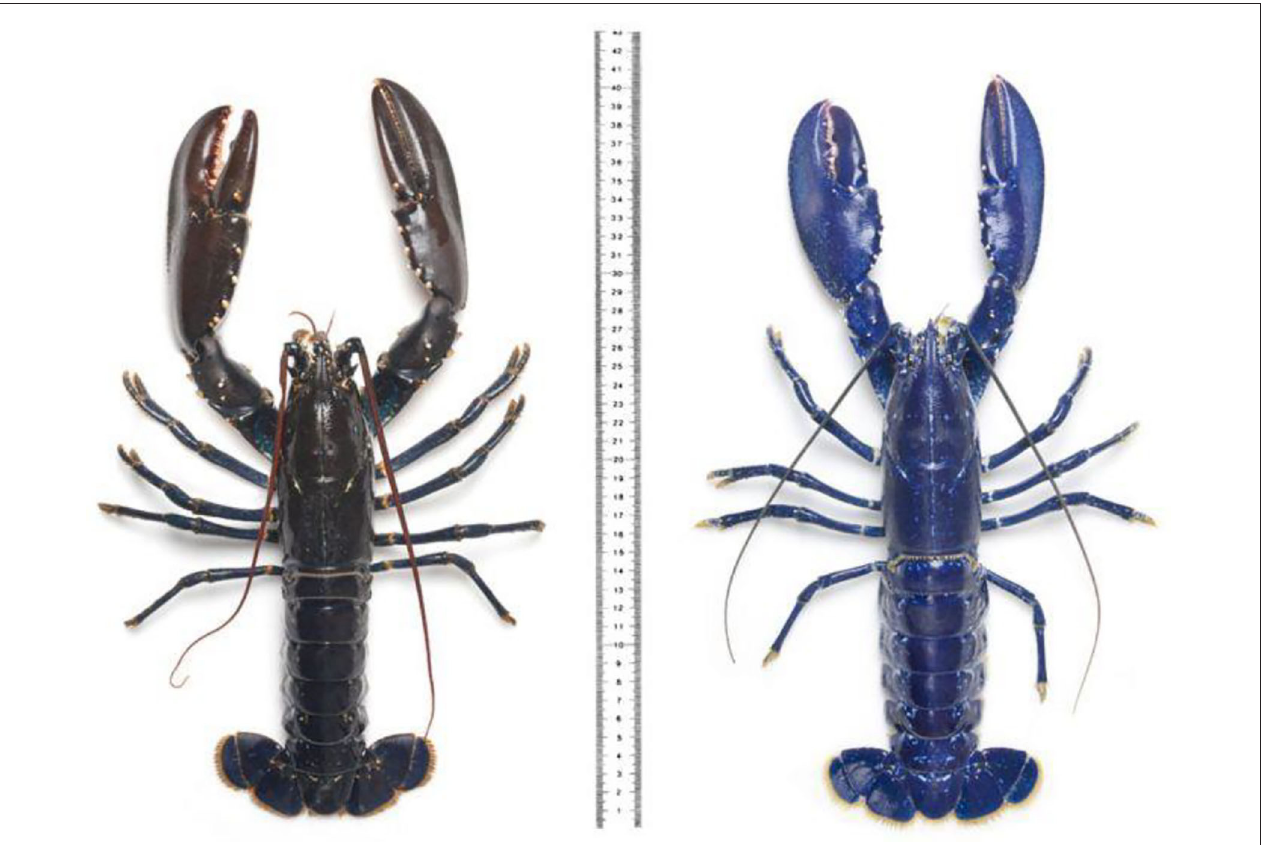
FIGURE 4 | Blue lobsters are exceedingly rare. This one of the blue foods that is though to be a sign of good luck for the fishermen who catch them. There is no mention that blue lobsters are unappealing. Though note that only the inedible carapace is blue, the flesh is white. Parkinson (2016) (photo from the Science Photo